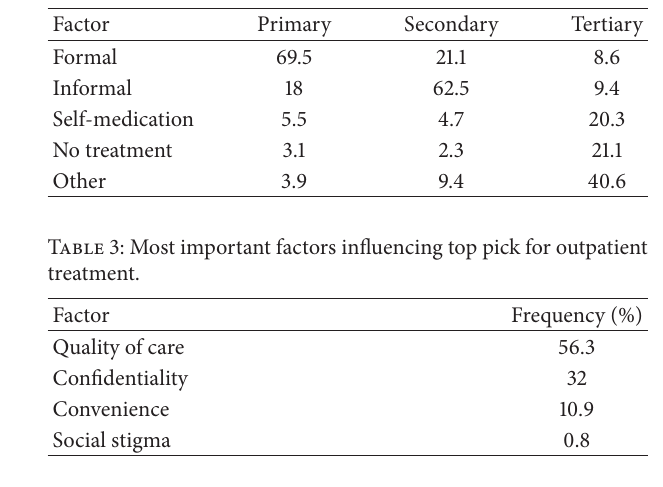
Table 4: Top picks for inpatient services.